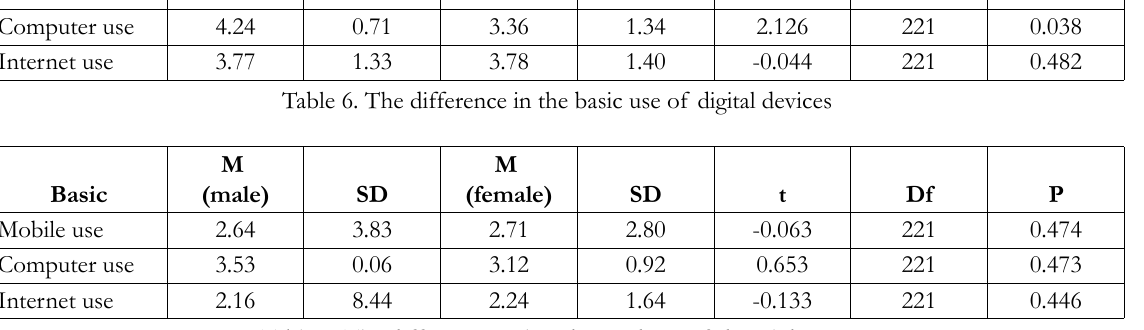
Table 7. The difference in the advanced use of digital devices